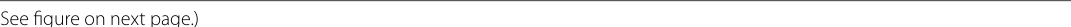
(See figure on next page.) Fig. 2 Comparison between the temporal variations of the Ca + profiles of the simulated results and the lidar observations with a height/time resolution of 0.5 km/600 s. The left column shows the simulated results and the right column the lidar observations for 6 nights: December 8, 2015 ( a and b ), December 18, 2015 ( c and d ), August 31, 2016 ( e and f ), December 24, 2014 ( g and h ), August 21, 2014 ( i and j ), and September 1, 2016 ( k and l